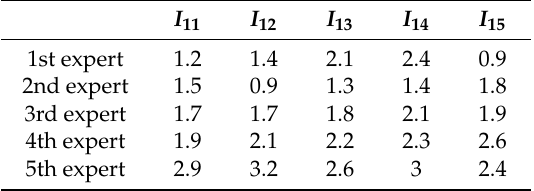
Table A17. Scores of environmental management maturity in the initiating process index.